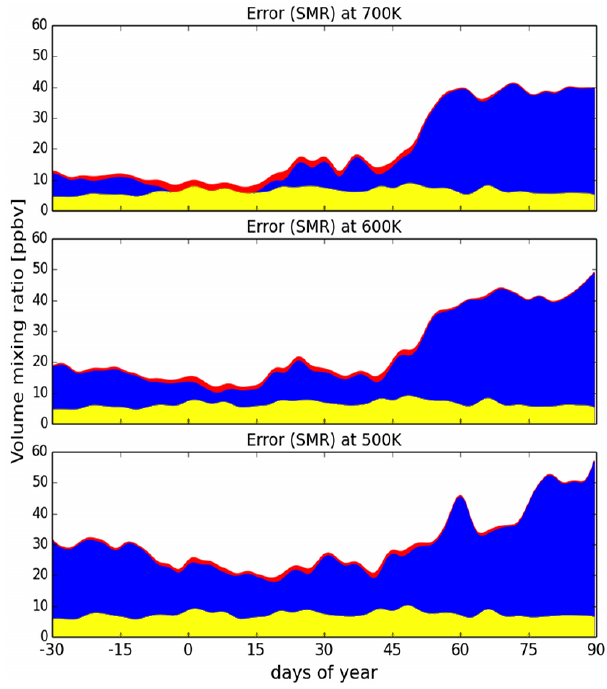
Figure 6. The estimated uncertainty of the vortex mean of N 2 O. The Fig. 6: The estimated uncertainty of the vortex mean of N 2 O. The blue area shows the standard blue area shows the standard deviation ( σ ) inside the vortex (EQL deviation ( σ ) inside the vortex (EQL 70). The yellow area shows the vortex mean of the error ≥ 70). The yellow area shows the vortex mean of the error fields ≥ fields ( ˆ E ). Finally, the red area indicates the total estimated error, which has been calculated as ( ˆ E ). Finally, the red area indicates the total estimated error, which p σ 2 + ˆ E 2 and is shown as uncertainties in has been calculated as σ 2 + ˆ E 2 and is shown as uncertainties in Figure 5. All data are smoothed over 3 days. Fig. 5. All data are smoothed over 3 p